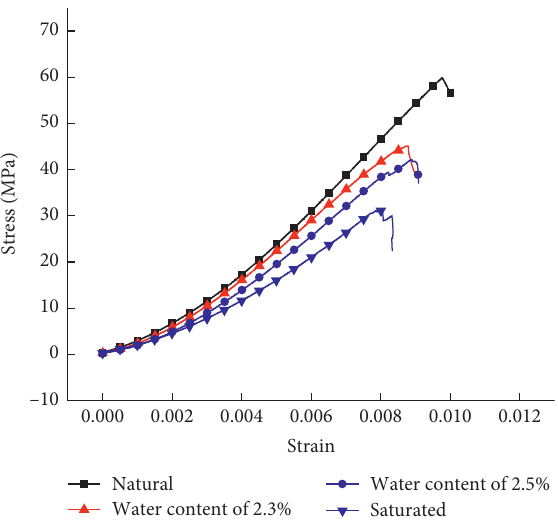
Figure 3: Stress-strain relations of rocks with open crack in dif- ferent water-bearing